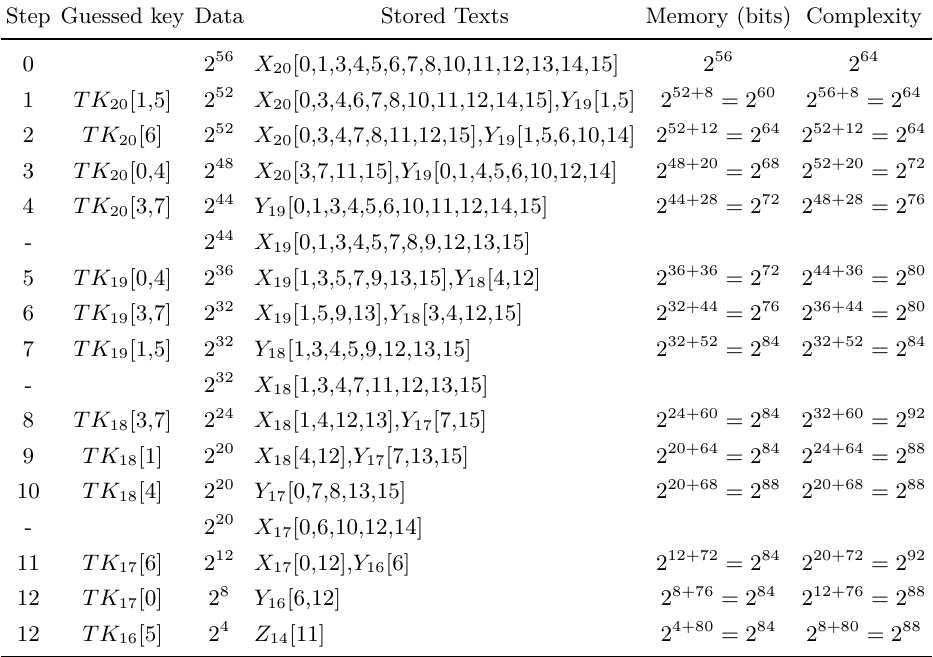
Table 3: Procedure for the key-recovery on Skinny